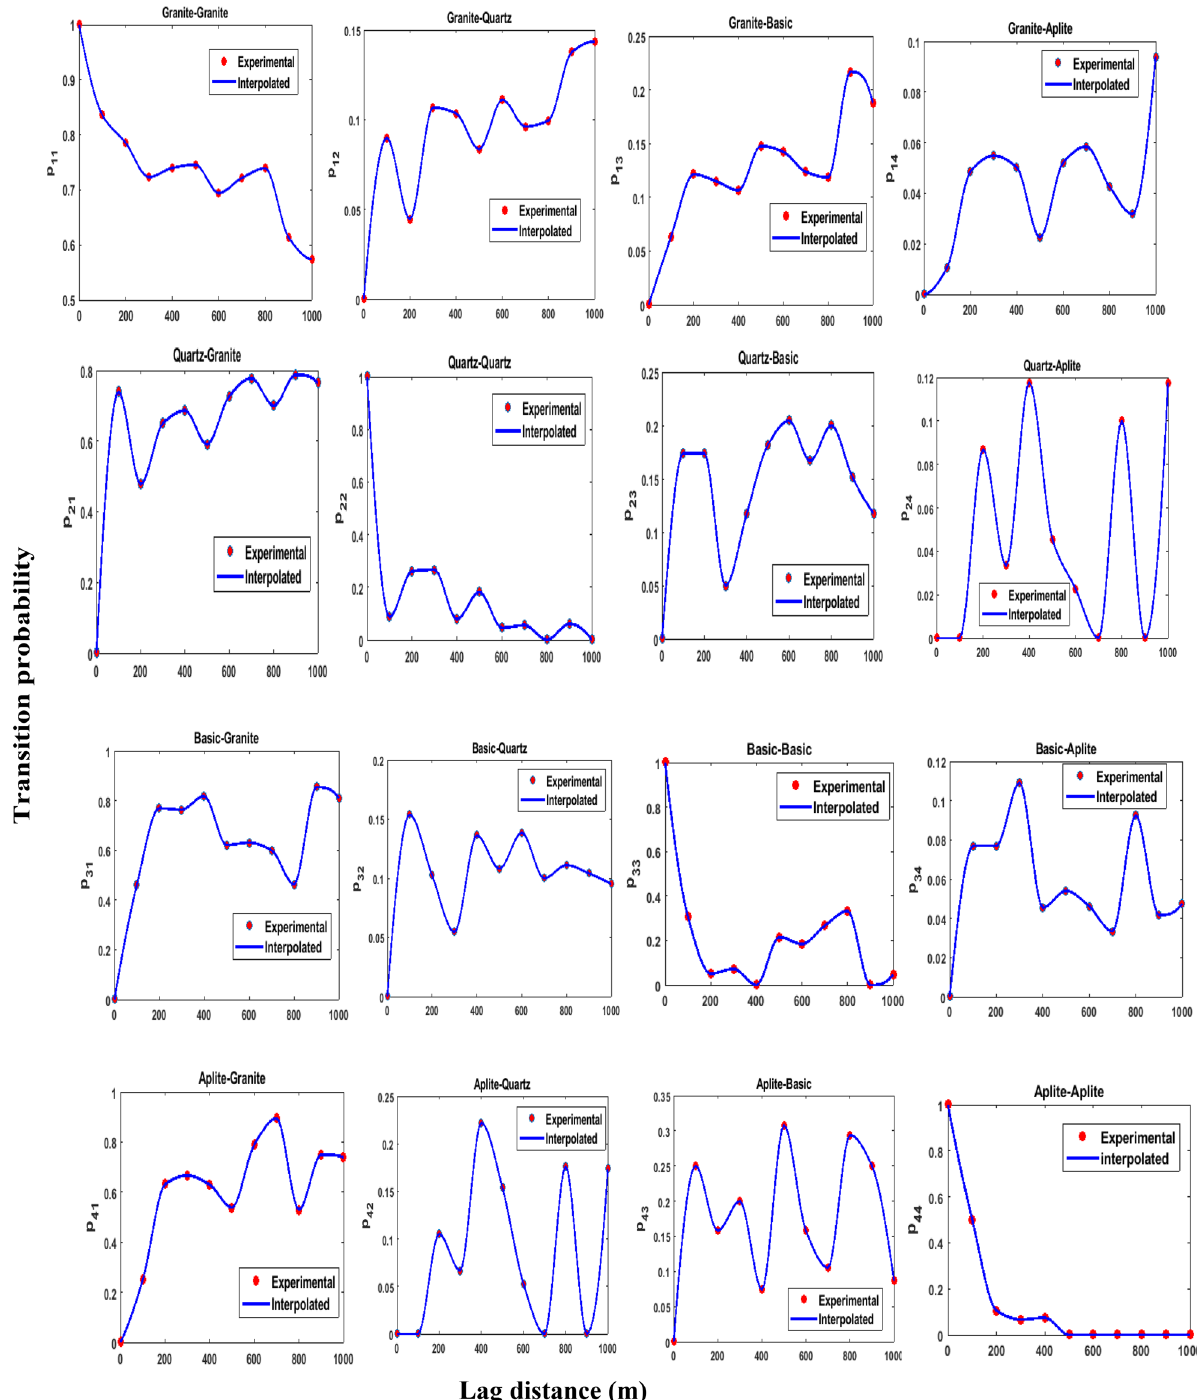
Figure 6. Experimental auto/cross transiograms and theoretical transiograms based on nonlinear interpolation for four lithotypes (granite; quartz; basic; aplite) at different lag